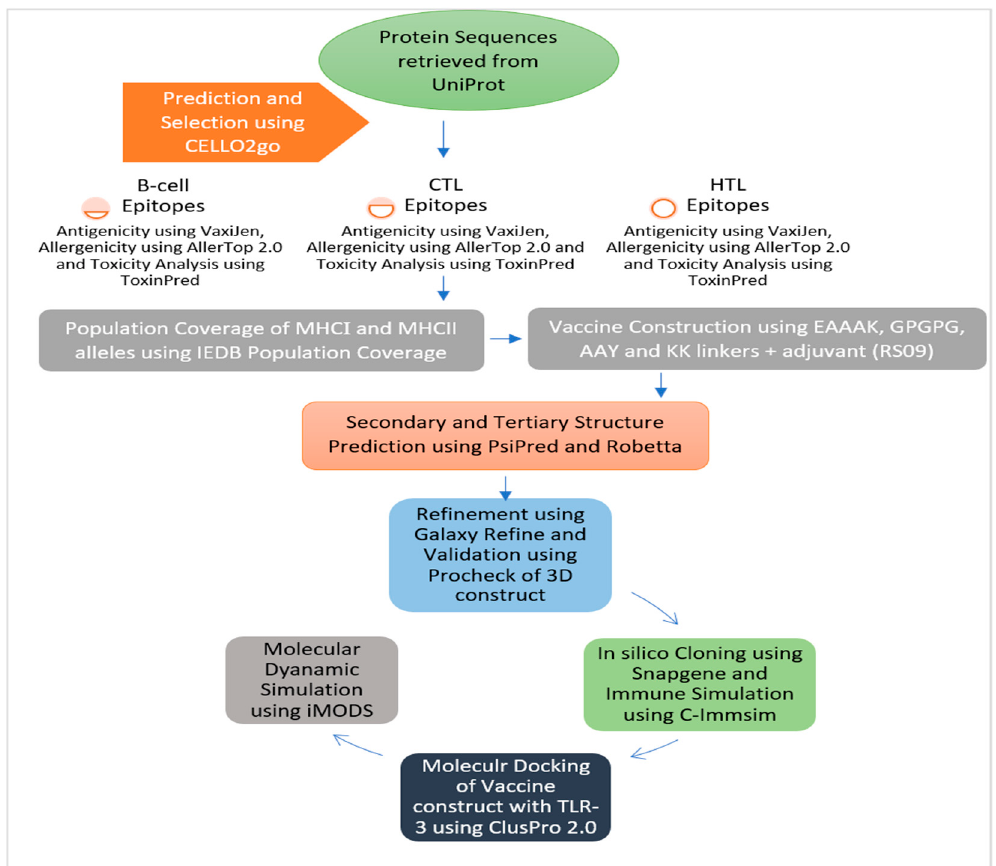
Figure 1. Flowchart diagram of designing mRNA- and peptide-based vaccine construct against emerging MDR Citrobacter freundii .